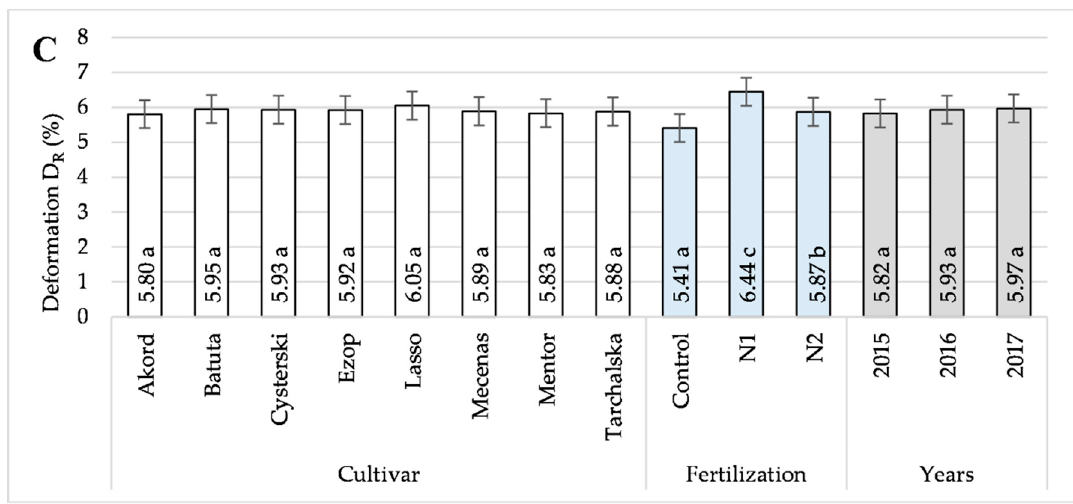
Figure 2. Average values of mechanical parameters depending on the cultivar, fertilizer treatment, and year of research: ( A )—Destructive force F D (N), ( B )—destructive energy E D (mJ), and ( C )—relative deformation D R (%). Statistical analysis was carried out separately for each factor (cultivar, fertilization, and year). Means followed by different letters show significant differences ( p < 0.05) according to the Tukey test. The differences are marked with letters a–c.